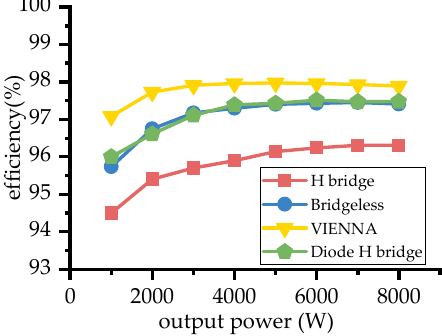
Figure 9. Efficiency versus output power for different rectifier.